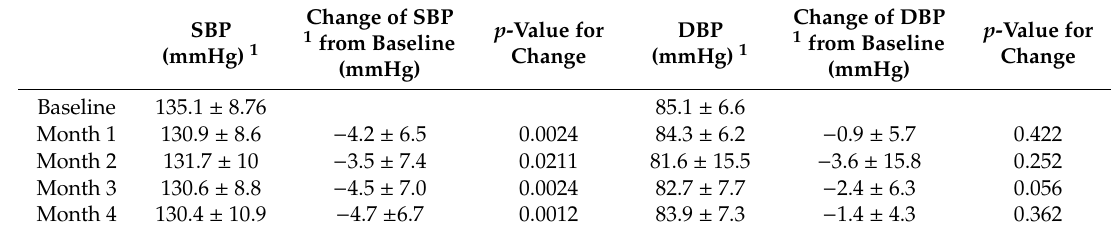
Table 5. Mean SBP and DBP and changes from baseline in BP values during four-month study